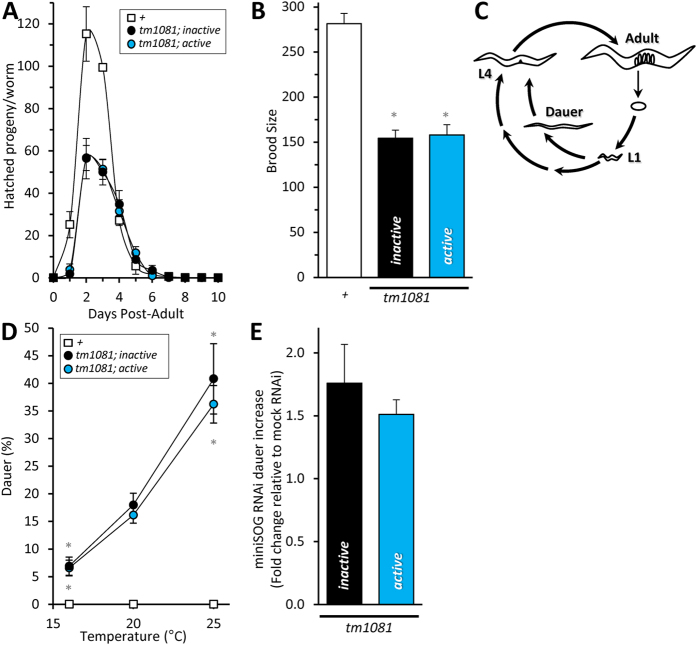
Complementation of a mev-1(tm1081)III deletion mutant with a transgenic mev-1(+)::miniSOG single-copy insert.The loss of mev-1 is lethal, hence tm1081 can only be maintained as a heterozygote through the use of a genetic balancer. Here, the mev-1(+)::miniSOG fusion was expressed in trans to the tm1081 deletion on chromosome II, and worms that were homozygous at both loci were used to assess: (A) Daily offspring production from staged L4 larvae and (B) The total number of viable progeny per worm. Data are mean ± SEM. N = 4–7. An “N” is considered an independent trial of up to 5 worms. *Adjusted P < 0.05 vs N2 (1-way ANOVA with TUKEY multiple comparisons test). Wild-type (+) brood size is reproduced from Fig. 1B for comparison. (C) A schematic representing the C. elegans life cycle. C. elegans progress through four larval stages (with intervening molts) to become a reproductively mature adult. Following the L1 larval stage, worms can arrest in an alternative “dauer” stage, which generally occurs in response to limiting factors in their environment such as a lack of food or crowding. Dauer larva are highly resistant to stress, age very slowly, and have an altered metabolism. (D) Temperature-dependent dauer entry in tm1081 mutants complemented using mev-1::miniSOG transgenes. Worms were synchronized via a 2-hour egg lay. Eggs were seeded onto a NGM plated with OP50 and incubated for the indicted time. Two days post-egg lay, the number of dauer-arrested worms was scored. Data are mean ± SEM. N = 6–9. *Adjusted P < 0.05 vs 20 °C per genotype (2-way ANOVA with Tukey multiple comparisons test). (E) RNAi targeting of miniSOG exacerbates the dauer phenotype. Data are mean ± SEM. N = 3. The second generation grown on RNAi for miniSOG was lethal. Alleles are abbreviated as outlined in Fig. 1.